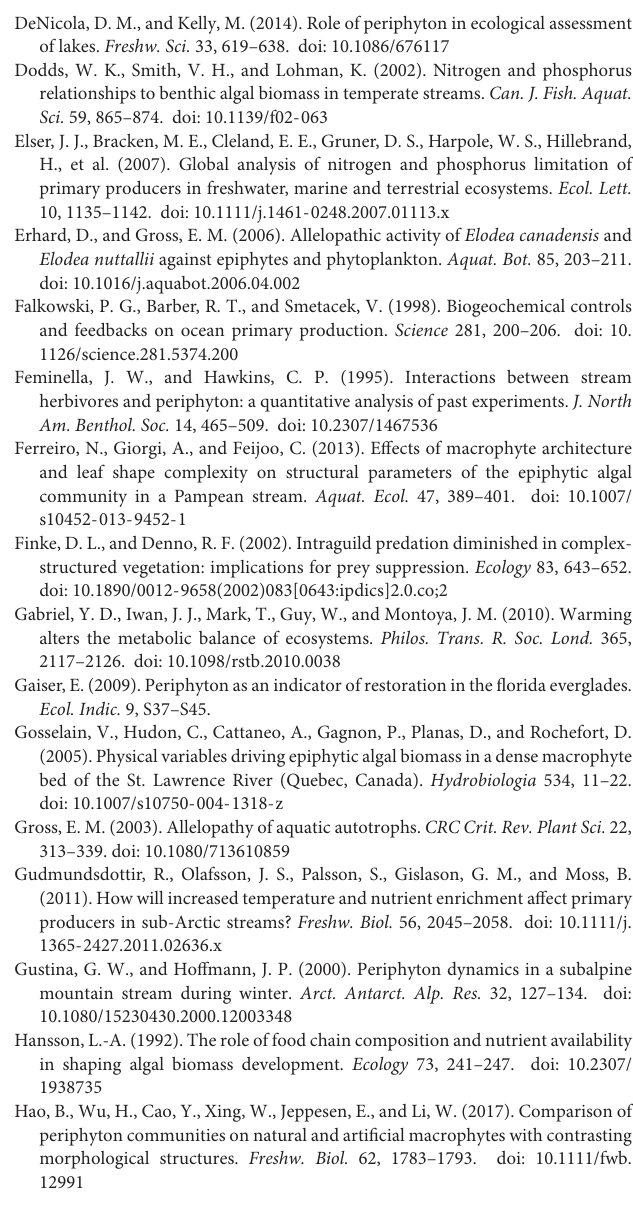
warming), nutrient*temperature and plant type (four levels: natural P. crispus , artificial P. crispus , natural E. canadensis and artificial E. canadensis ) on the Richness, Shannon-Wiener and Pielou indexes of periphyton. All bolded values in the tables are significant at p < 0.05. TABLE S5 | RDA results of environmental variables selected by forward-selection procedures and permutation tests for the RDA models in the clear-low-nutrient state and the turbid-high-nutrient state in May, August, November and February. P values represent the results of permutation tests for the models, and R2 and R2 adjusted are the cumulative proportions explained by the models. All bolded values in the tables are significant at p < 0.05. TABLE S6 | Results of two-way PERMANOVA comparing the effects of nutrient (two levels: low and high), temperature (three levels: ambient, warming and enhanced warming) and their interactions on the functional group composition of periphyton. All bolded values in the tables are significant at p <